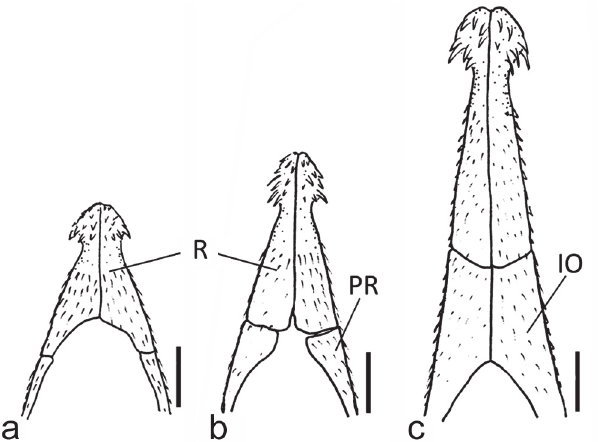
Fig. 8. Spatulate projection of snout of: a) Acestridium triplax , MCP 41746; b) A . discus , MZUSP 85322; and c) A . martini , MZUSP 74275. IO = infraorbital; PR = postrostral plate; R = rostral plate. Ventral view, anterior towards top. Scale bar = 1 mm. Modified from Reis & Lehmann